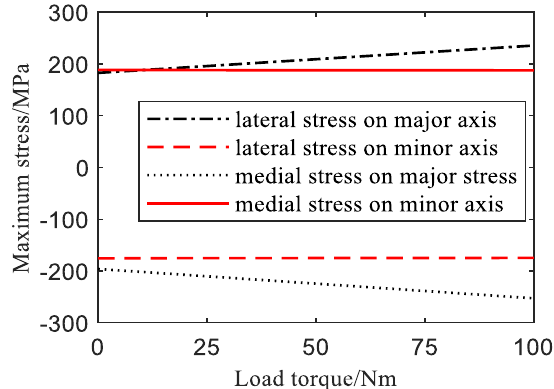
Fig. 15. The in fl uence of load torque on the maximum bending normal